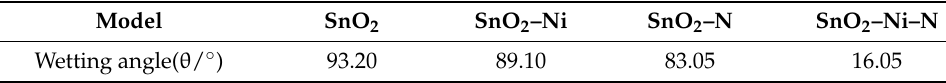
Figure 6. Wetting angles ’ test diagrams: ( a ) SnO 2 ; ( b ) SnO 2 – N; ( c ). SnO 2 – Ni; ( d ). SnO 2 – Ni – N. Table 6. The wetting angle of Ag and SnO 2 under different